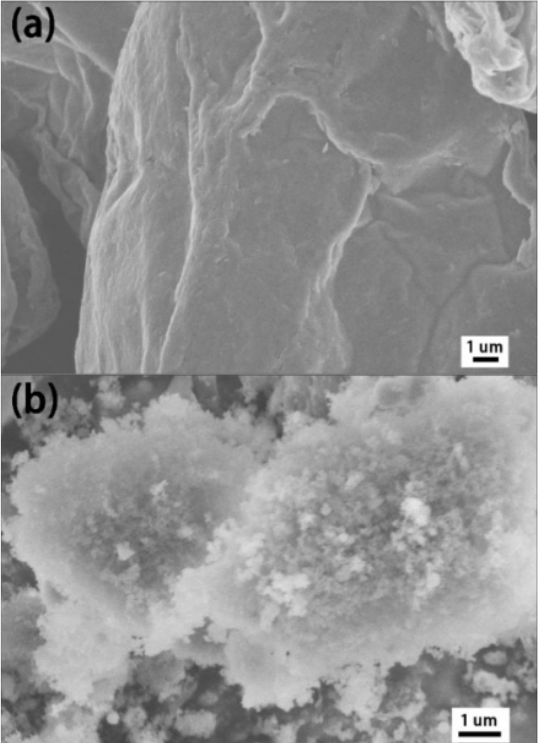
Figure 2. SEM images of GO nanosheets: ( a ) before surface modification GO, ( b ) after surface modification f-GO ( b ).